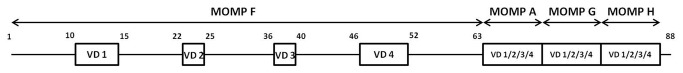
Layout of

C

. pecorum
 MOMP peptide library.Peptides 1 to 63 represent five conserved domains (straight lines) interspersed by four variable domains (boxes) of MOMP F. Peptides 64 to 88 represent four variable domains of MOMP A, MOMP G and MOMP H, respectively.